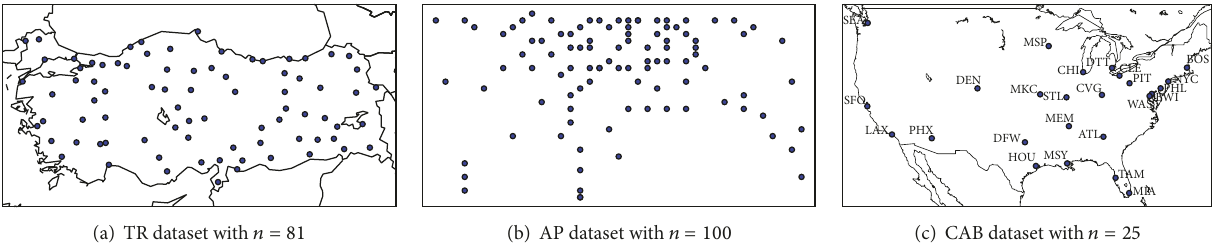
Figure 4: Visualization of three datasets used in this study: TR dataset, AP dataset, and CAB